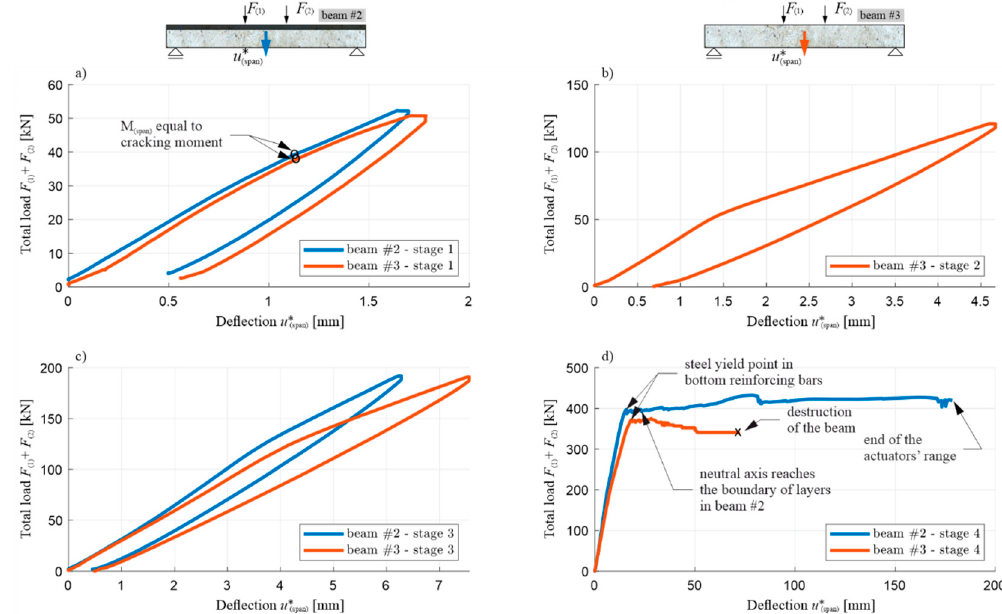
Figure 27. Diagram of the total load in the function of the deflection at the middle of the span for beams #2 (blue line) and #3 (red line): ( a ) stage 1, ( b ) stage 2, ( c ) stage 3, ( d ) stage 4.